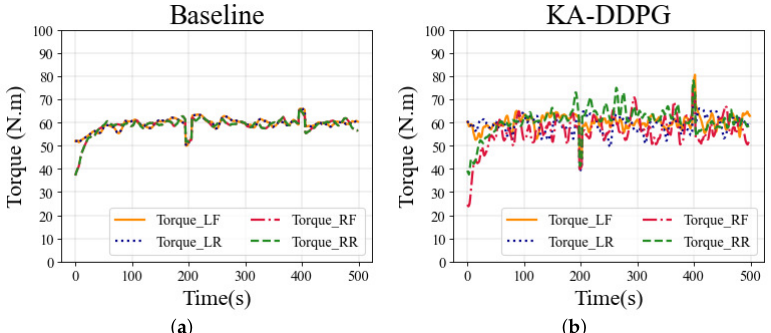
Figure 9. Torque distributions in the straight scenario: ( a ) baseline and ( b )